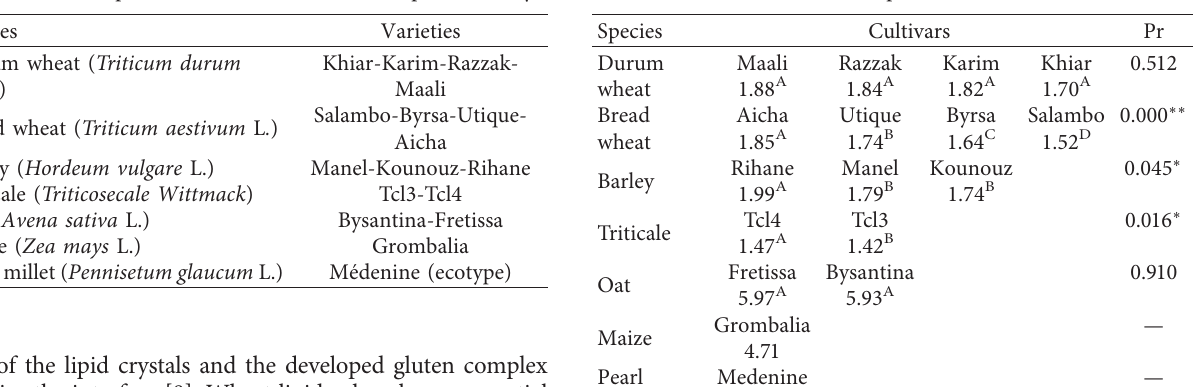
Table 2: Variation of total lipid (%) of the cereal